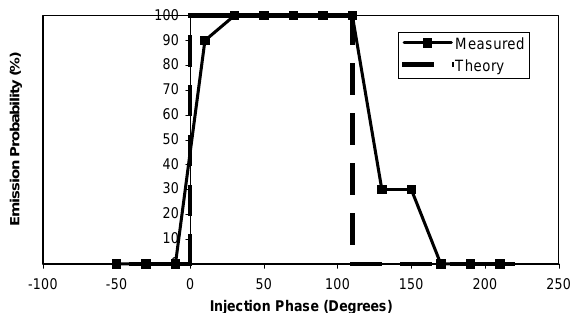
FIG. 6. Measured probability of laser induced electron emis- sion from the RF gun as a function of RF phase shifter setting. Comparison to that predicted from theory suggests a phase sta- bility of about 6 15 ± (or 2